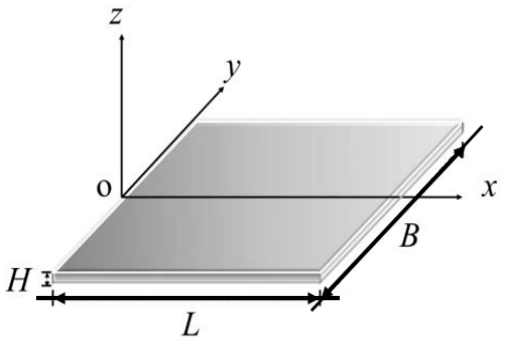
Figure 1. Model of a